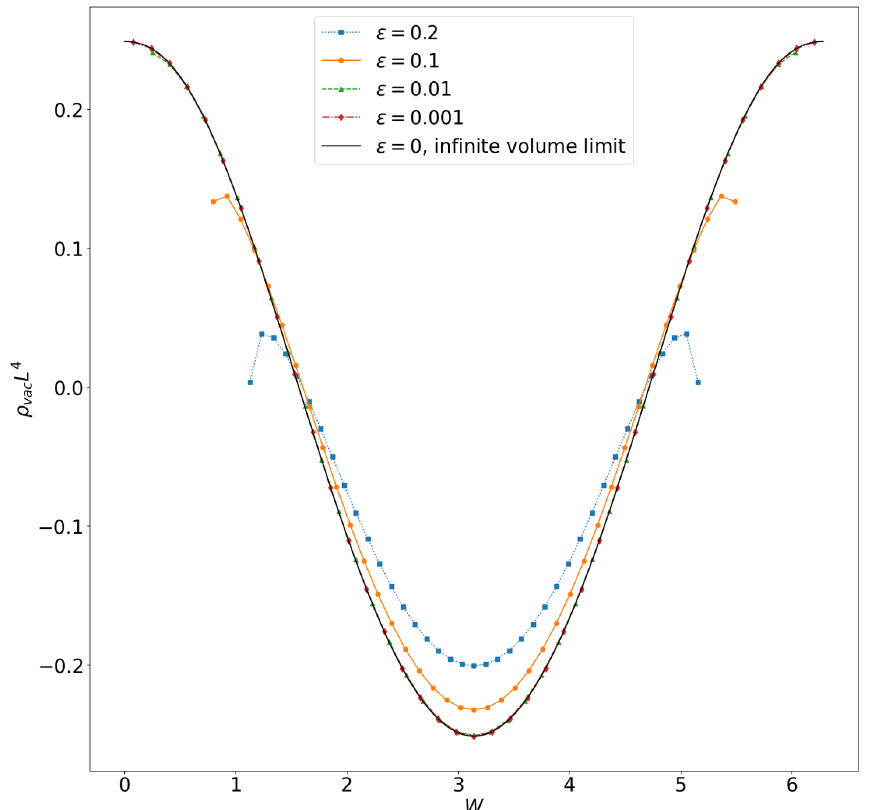
Figure 5 . The dimensionless vacuum energy as a function of the dimensionless parameter, W , for dYM with n = 2 flavours of fermions with mass LM = 1 . 00 . The numerical evaluation used f N n = 100000 and N p = 500 as the upper limit for the n - and p -sums in equations (4.11) and (4.13). The upper limit for the Taylor series in equation (4.17) was taken to be N = 500 . The numerical m reliability breaks down near the boundary of the region without a tachyon, so the plot is only covers hq q i the values in the interval, . The value diverges down to negative infinity as W 2 π(cid:15) 2 π(cid:15) , 2 π − 0 . 99 0 . 99 √ √ approaches the values W = 2 π(cid:15) and W = 2 π − 2 π(cid:15) making the W = π vacuum metastable. The infinite volume limit was calculated from equation (4.21) using the upper bound N = 500 p